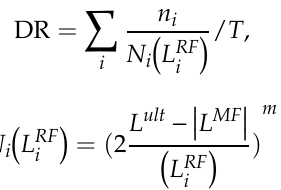
Table 12. Standard deviations of the SWAY model for various water depths (U mean = 11.4 m / s). Wave Condition Surge (m) Pitch (deg) H s (m) T p (s) 100m 200m 300m